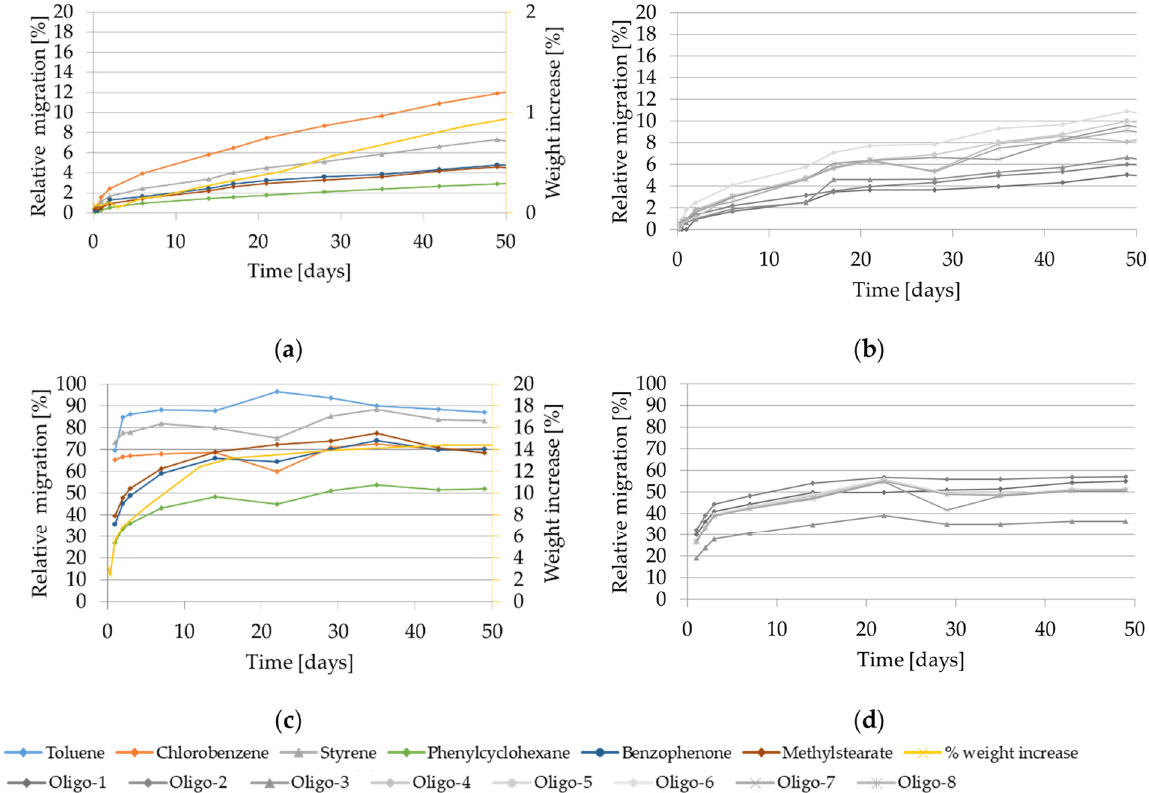
Figure 2. Migration kinetics and weight increase in isooctane at 40 °C: ( a ) Model substances and styrene from GPPS; ( b ) Styrene oligomers from GPPS. ( c ) Model substances and styrene from HIPS;